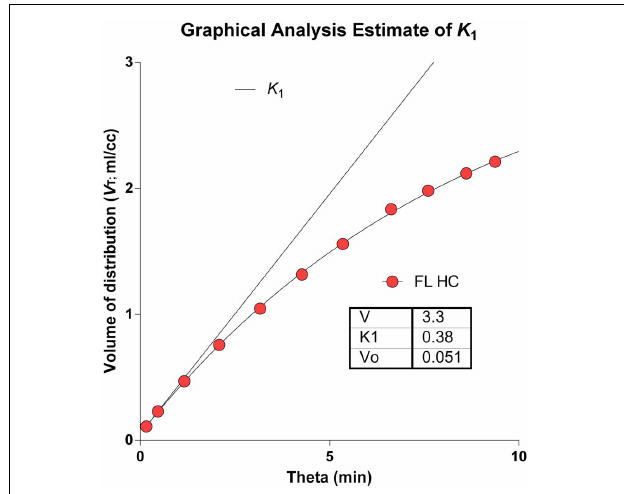
FIGURE 7 | Idealized clearance and actual uptake of [ 11 C ] PiB into frontal lobe of healthy volunteer. Determination of brain microvascular Permeability-Surface Area products (PS) rests on measure of initial blood-brain transfer, or clearance, symbolized by term K 1 . Abscissa: Normalized time ‘Theta’ (minutes) as defined in Equation 2. Ordinate: Apparentvolumeofdistribution(ml/cm 3 ).Notethat [ 11 C ] PiBuptakeintobrain tissue is partially flow-limited for only a few moments after